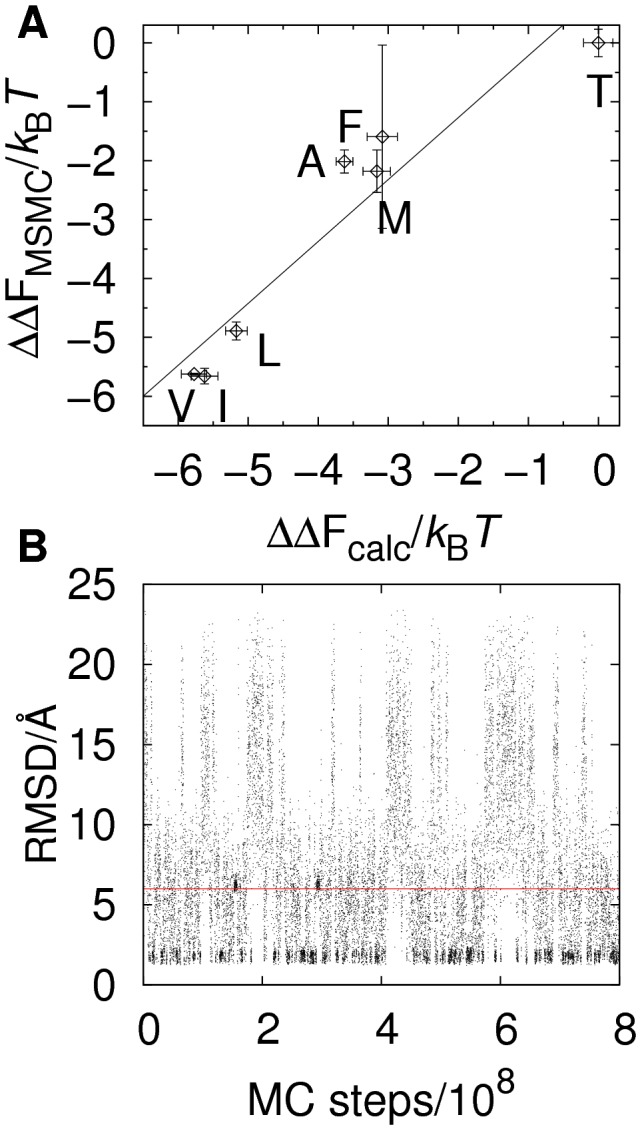
Relative binding free energies from computational peptide screening.We applied the peptide screening method to the protein PSD95 with the peptide KKETE-, where  denotes a variable amino acid position. Relative binding free energies, , for the different possible peptide sequences , were estimated from the distribution  obtained in the second step of the screening procedure (see Figure 1) and using the relation . (A) Comparison between  and  values for the -variants in Figure 2. The correlation coefficient is . Standard errors for  are estimated from 3 independent screening runs. As in Figure 2, the binding free energies are shown relative to the weakest binding peptide. (B) Example of a peptide screening run of PSD95 showing the evolution of RMSD, which measures the structural similarity of the peptide chain to the experimental structure, as a function of the number of elementary MC steps. The definition of bound state, RMSD<6 Å, is indicated by a horizontal line.